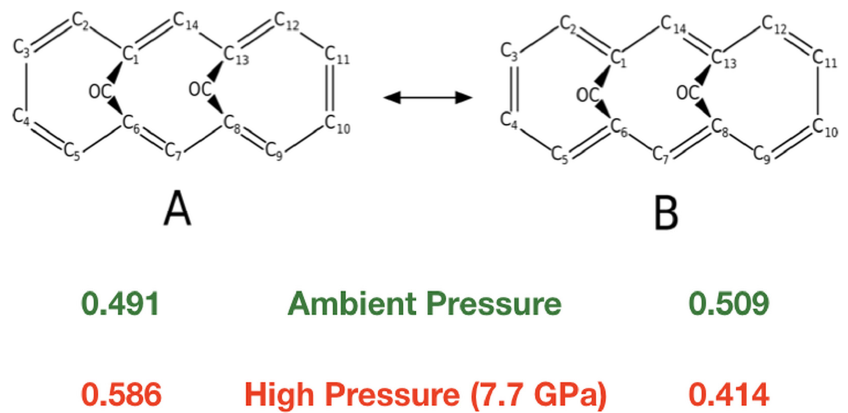
Figure 2. Resonance structures of the syn-1,6:8-13-biscabonyl[14]annulene (BCA) and corresponding Chirgwin–Coulson weights resulting from X-ray restrained ELMO valence bond (XR-ELMO-VB) computations at ambient pressure and at 7.7 GPa (with correlation-consistent polarized valence double-zeta basis-set).